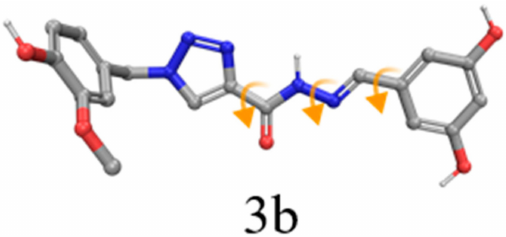
Figure 8. Compounds with rotatable bonds fixed during the docking experiments (orange arrows). Dihedrals not highlighted in this picture were defined as free to rotate, except amide